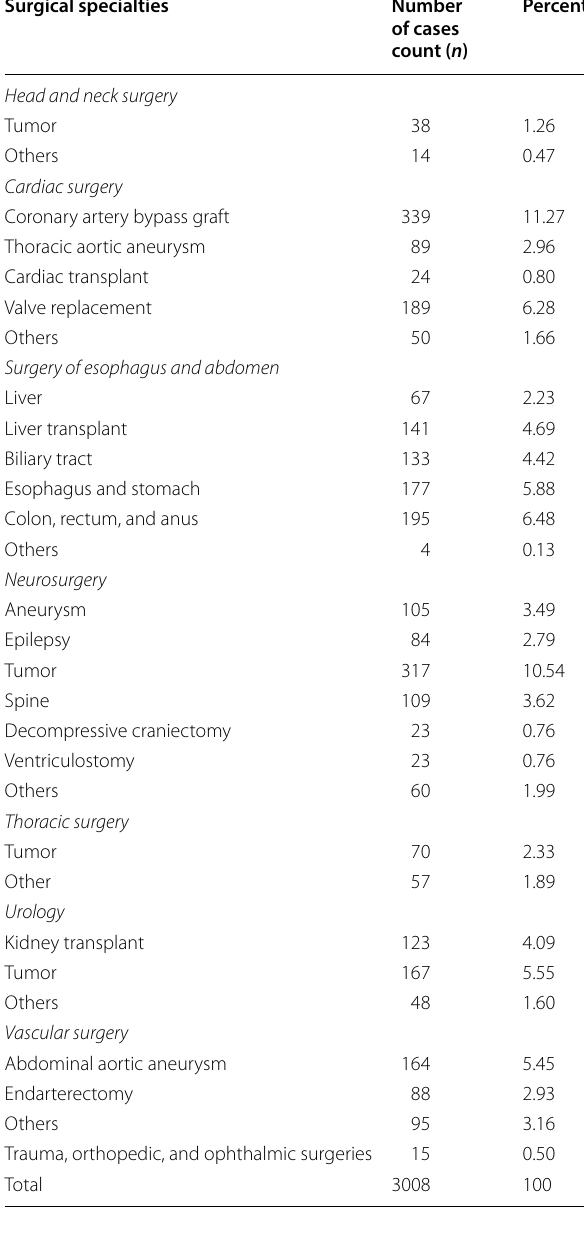
Table 2 Type of surgery distribution across patients Surgical specialties